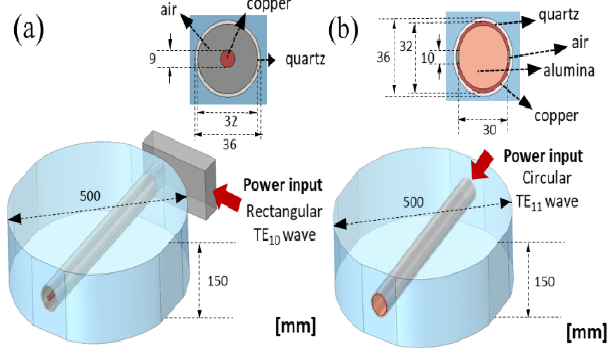
Figure 6. Geometry of MWP 3-D simulation ( a ) quasi-coaxial TEM linear MWP and ( b ) circular TE 11 waveguiding structure.